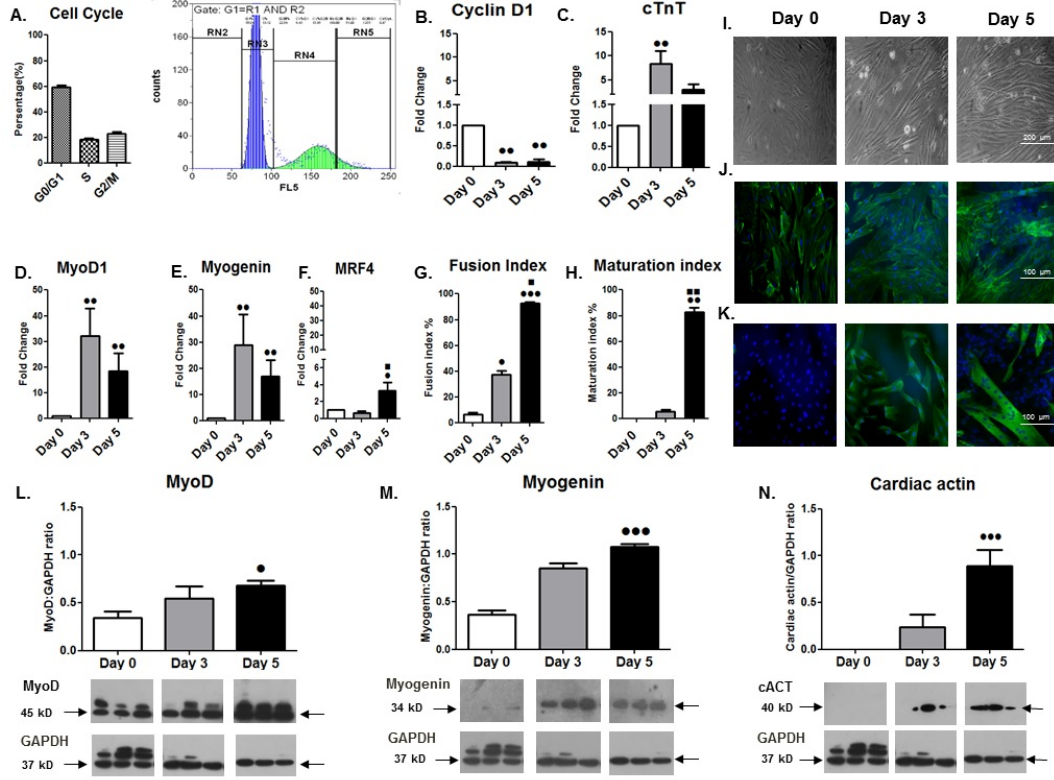
Figure 1. ( A ) Cell cycle progression of undifferentiated H9C2 cardiomyoblasts. Percentages of cells in each phase represent a normal cell cycle phenotype of H9C2 cardiomyoblasts. ( B , C , N ) Expression of cell cycle regulator Cyclin D1 and cardiac-specific markers during H9C2cardiomyoblast differen- tiation. Quantitative transcriptional analysis of Cyclin D1 revealed its downregulation during the differentiation process of cardiomyoblasts ( B ), along with the upregulation of the cardiac-specific markers troponin ( C ) and actin ( N ) (representative Western blot and immunoblotting quantification of cardiac actin). ( D – F ) Myogenic regulatory factors’ expression during cardiomyoblast differentia- tion. Quantitative analysis of the mRNA expression of muscle-specific transcription factors MyoD1, Myogenin, and MRF4 revealed a differential expression pattern, e.g., of early (MyoD1) vs. late (MRF4) myogenic factors in cardiomyoblasts during their differentiation. ( L , M ) Representative Western blots and immunoblotting quantification of MyoD ( L ) and Myogenin ( M ) protein expres- sion are given. The mRNA expression values of each gene of interest have been normalized to the corresponding GAPDH mRNA and are expressed as fold changes. The expression of the proteins was also normalized to each corresponding GAPDH on the same immunoblot. The same blot has been used for GAPDH in ( L – N ). ( I – K ) Morphology-based analysis of H9C2 cardiomyoblasts during differentiation. Brightfield microscopy shows cardiomyoblast alterations over time during their differentiation process ( I ). Morphology alterations were further analysed using fluorescent DAPI, Phalloidin ( J ), and MyHC ( K ) immunostaining, documenting that these cells possess a myogenic differentiation potential. ( G , H ) Fusion and maturation index. Fusion index and ( G ) maturation index ( H ) values were calculated in cardiomyotubes immunostained with MyHC. Myotubes